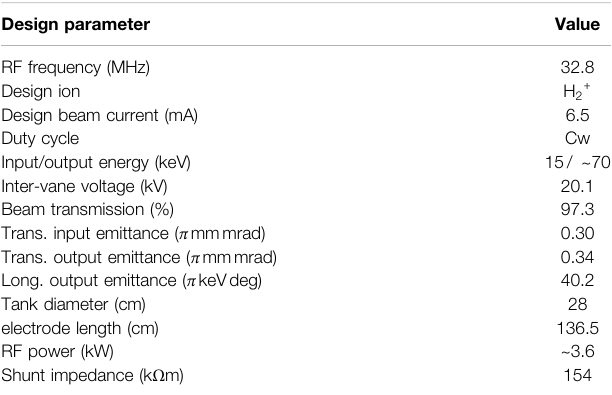
TABLE 1 | Basic parametersof the IsoDAR-RFQ, corresponding to the previously developed baseline beam dynamics design and the preliminary RF/ mechanical